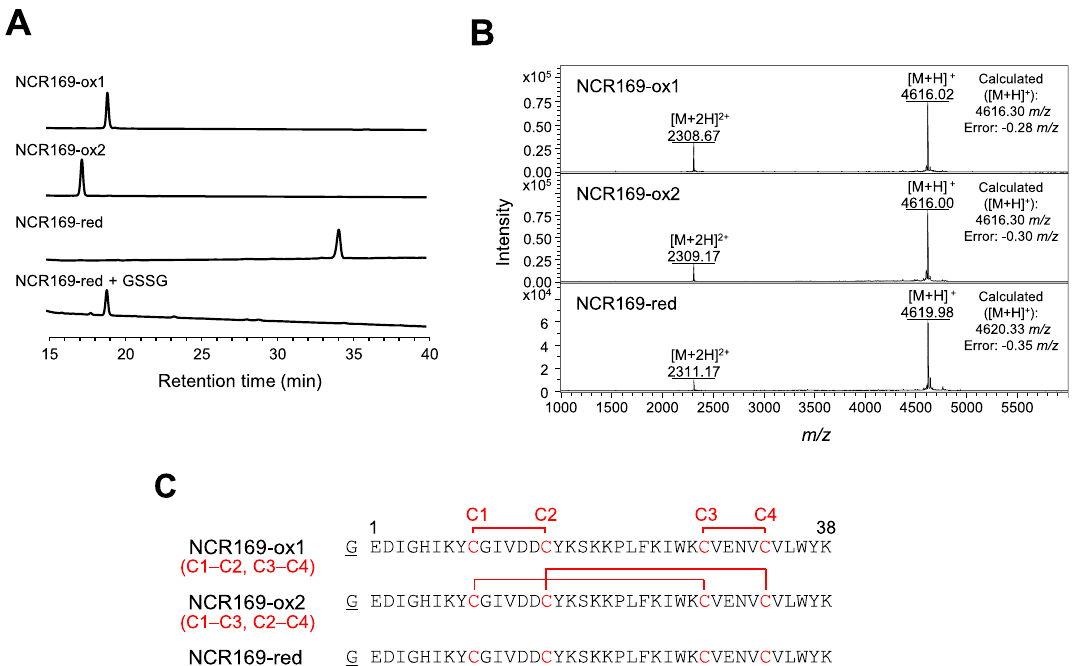
Figure 1. Sample preparation of NCR169 peptides. ( A ) High-performance liquid chromatography (HPLC) analyses of NCR169 peptides. Purified NCR169-ox1, NCR-ox2, NCR169-red, and reoxidized NCR169-red (NCR-red + GSSG) were analyzed by HPLC with a linear gradient of 30 to 45% acetonitrile and monitored at 220 nm. ( B ) MALDI-TOF–MS spectra of HPLC-purified NCR169-ox1 (upper), NCR169-ox2 (middle), and NCR169-red (lower). ( C ) Amino acid sequences of NCR169 peptides used in this study. The cysteine numbers (C1 to C4) are indicated in red on the sequence. The experimentally determined disulfide linkage patterns are indicated by connecting lines on the sequences. The first N-terminal residue, G (underlined), is the extra residue remaining after tag